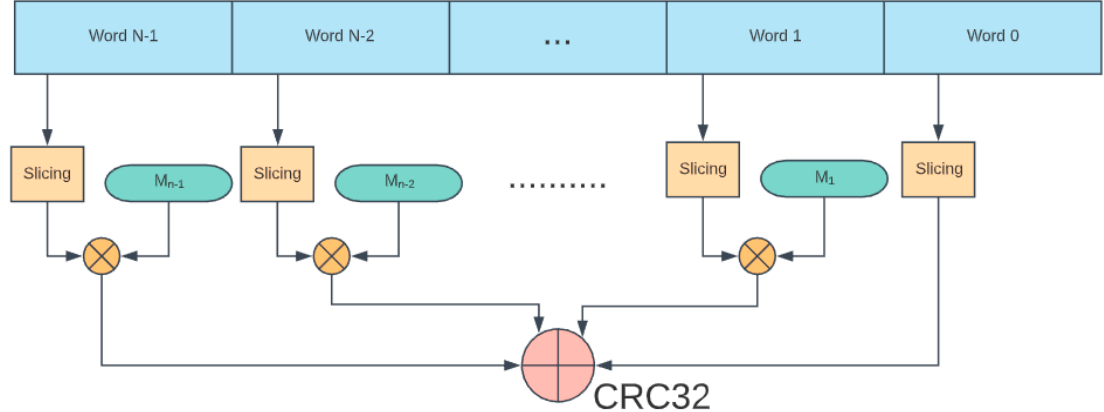
Figure 5. Hybrid system using both slicing-by-N and matrix transformation.